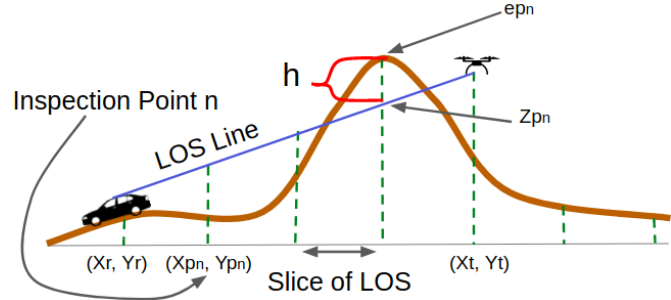
Figure 2. Detecting the Hills as Obstacles